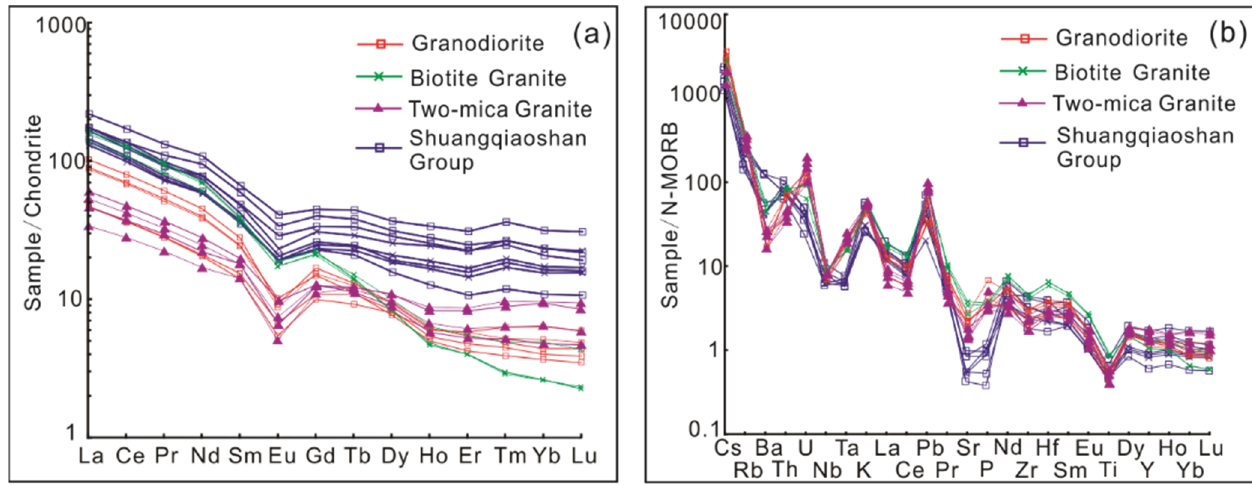
Figure 6. ( a ) Chondrite-normalized REE and ( b ) N–MORB-normalized trace-element spider patterns of the Zhuxi granites and Shuangqiaoshan Group (normalizing factors are from [65]; E–MORB, OIB, and N–MORB compositions are from [66]).